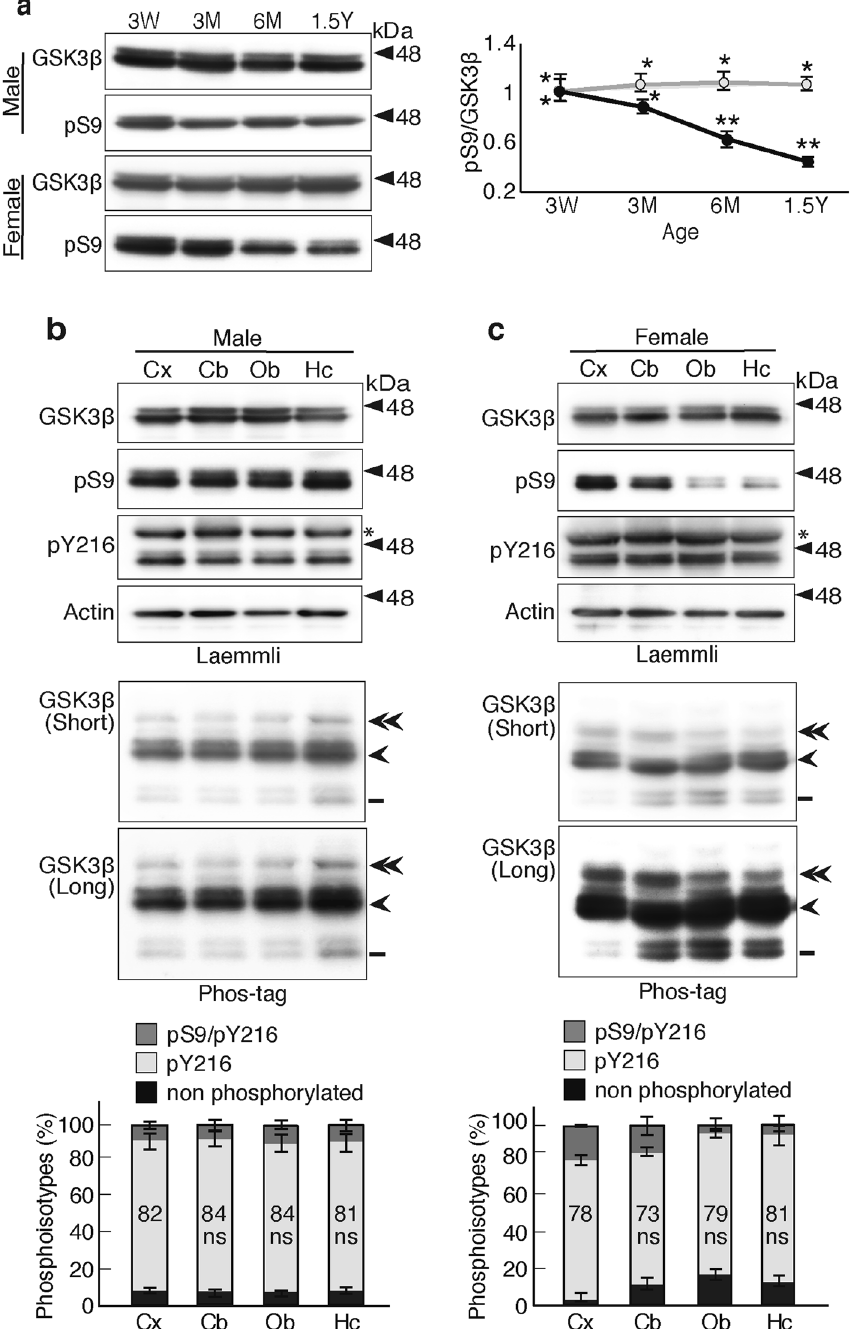
Figure 7. GSK3 β phosphoisotypes in mouse brains. ( a ) Expression and Ser9 phosphorylation of GSK3 β in mouse brain with aging. Extracts of hippocampus of male and female mouse at ages 3 weeks (3 W), 3 and 6 months (3 M and 6 M), and 1.5 years (1.5Y), were immunoblotted with anti-GSK3 β or anti-phospho-Ser9 after Laemmli’s SDS-PAGE. The ratio of phospho-Ser9 to total GSK3 β was quantified and expressed to the ratio at 3 weeks. Gray represents male and black represents female (means ± s.e.m. n = 6, * p < 0.05, ** p < 0.01, one-way ANOVA). ( b and c ) Analysis of GSK3 β phosphorylation in different regions of brains prepared from 1.5-year- old mice; cerebral cortex (Cx), cerebellum (Cb), olfactory bulb (Ob) and hippocampus (Hc). ( b ) shows the male mice and ( c ) shows the female mice. The top four panels show Laemmli’s SDS-PAGE and the lower two panels (upper, shorter exposure; lower, longer exposure) show Phos-tag SDS-PAGE that had been immunoblotted with the indicated antibodies. The percentages of three phosphoisotypes of GSK3 β are shown below the blots. Dark gray represents phospho-Ser9 and phospho-Tyr216 GSK3 β , light gray represents phospho-Tyr216, and black represents nonphosphorylated GSK3 β . The percentages of phospho-Tyr216 are indicated (means ± s.e.m. n = 6, ns, not significant). Uncropped immunoblots of GSK3 β , pS9, pY216 and actin after Laemmli’s SDS-PAGE and GSK3 β after Phos-tag SDS-PAGE are provided in Supplementary Fig.